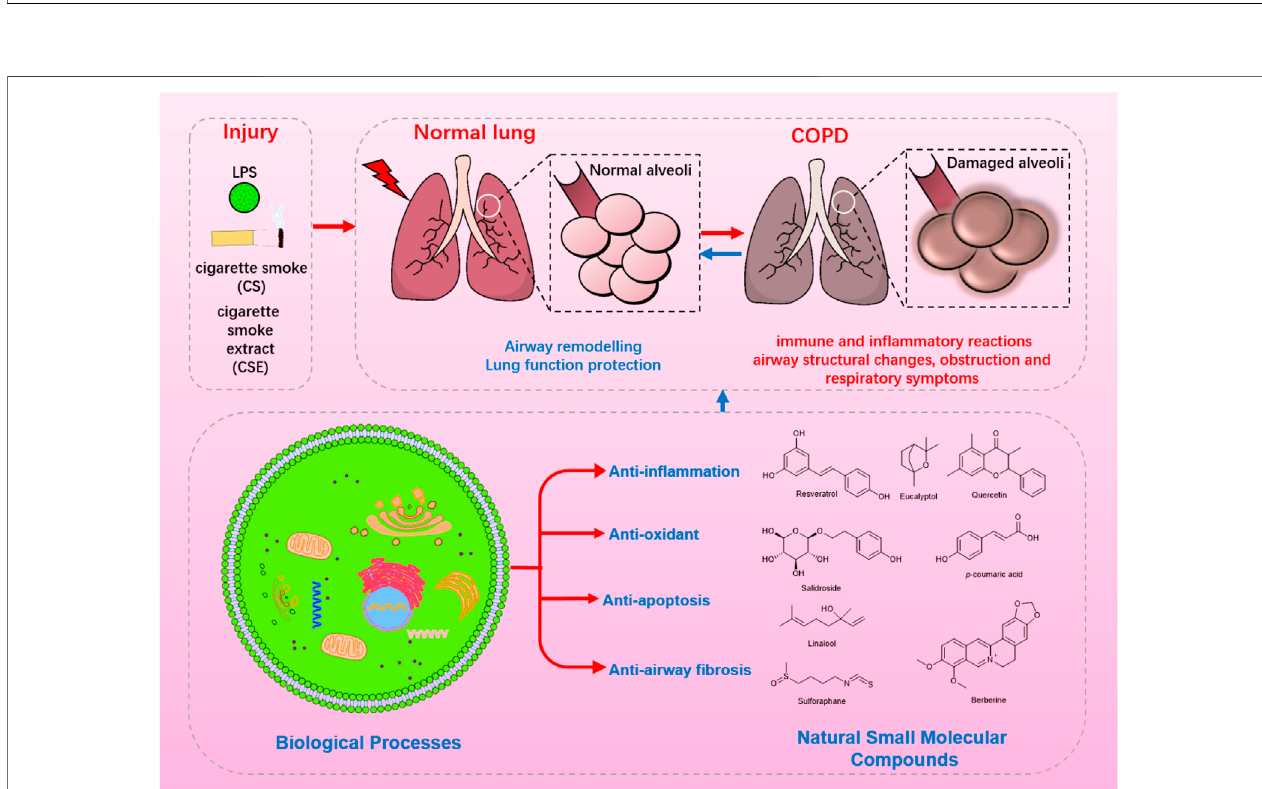
FIGURE 2 | The biological processes and mechanisms of natural small molecular compounds in the treatment of COPD.